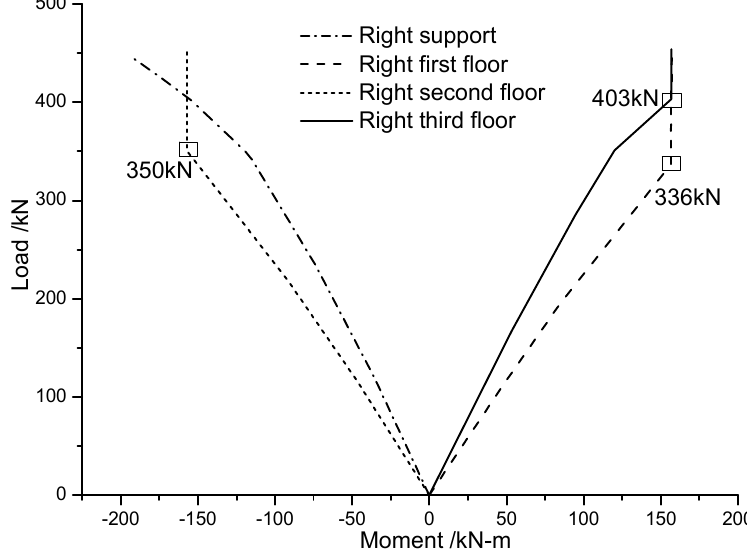
Figure 20. Load-Moment curves at the right joints and support.